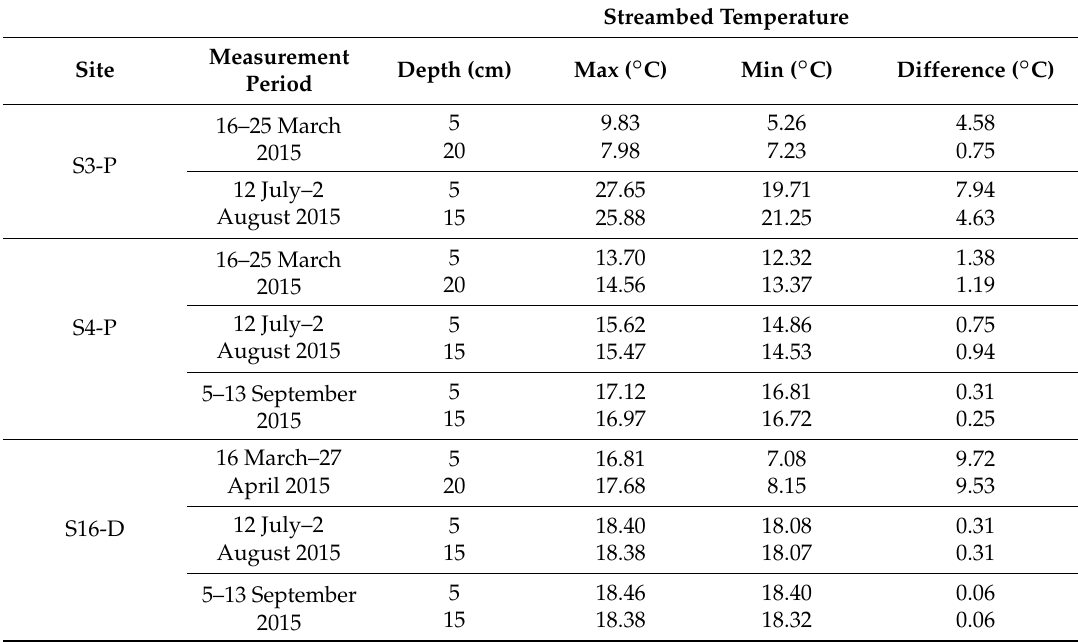
Table 1. Maximum and minimum values of the streambed temperatures at monitoring sites S3-P, S4-P and S16-D for each measurement